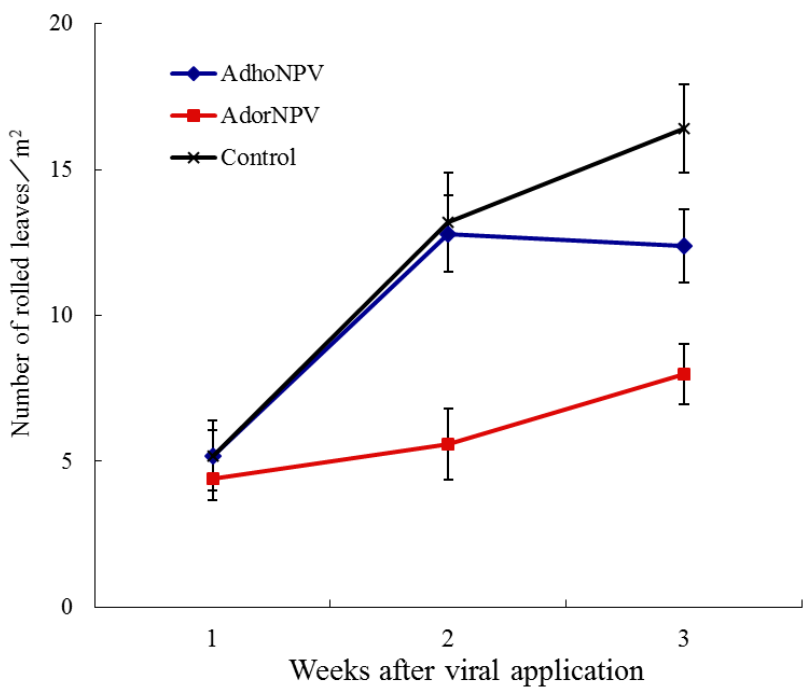
Figure 3. Number of rolled tea leaves produced by A. honmai larvae on tea plants in cages sprayed with AdhoNPV, AdorNPV, or virus-free control. Bars indicate standard errors. Damage areas in the treated plots were categorized to “Small”, “Medium”, “Large” and “Extra-Large” and the number of nests with damaged area were shown in Figure 4. The number of nests was less at 1 week because only visible nests were counted, and no significant difference was observed for “Small” and “Medium” damages among the treatment (Small, F = 0.0018, df = 2, 27, p = 0.998; Medium, F = 0.00, df = 2, 27, p = 1). At two weeks, more nests with “Large” damage were observed in the control and AdhoNPV-treatment than in AdorNPV, which was significantly different, as well as the number of “Medium” damages (Medium, F = 4.22, df = 2, 27, p = 0.0025; Large, F = 3.48, df = 2, 27, p = 0.045). At three weeks, damage areas in the control and AdhoNPV-treated cages were more than those in AdorNPV-treated cage. The number of nests in the “Large” and “Extra-large” categories in the control and AdhoNPV treatments were more than 50% of the total. In contrast, most of the nests in the AdorNPV treatment were “Small” (30%) and “Medium” (50%) (Figure 4). Number of leaves with “Small”, “Medium”, or “Large” damage were not significantly different among the three treatment (“Small”, F = 0.012, df = 2, 27, p = 0.98; “Medium”, F = 0.456, df = 2, 27, p = 0.64; “Large”, F = 2.25, df = 2, 27, p = 0.13), but number of leaves with “Extra-large” damage was significantly different ( F = 11.80, df = 2, 27, p = 0.0002). Tukey-Kramer multiple comparison among the three treatments revealed that number of leaves with “Extra-Large” damage in control was significantly more than that in either AdhoNPV or AdorNPV ( p < 0.05). Even though no significant difference was detected, number of leaves with “Extra-Large” damage was six-fold less in AdorNPV than in AdhoNPV ( p > 0.05). These results were in agreement with previous laboratory bioassays